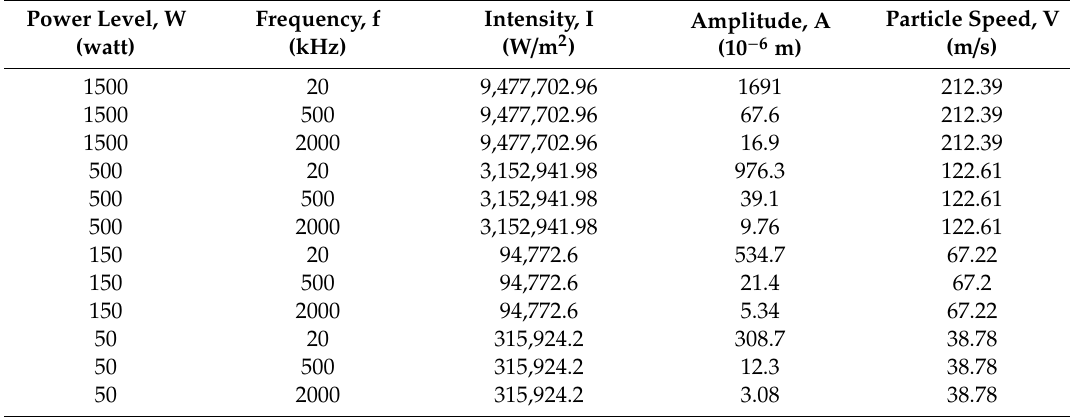
Table 2. Variation in resulting flow field.